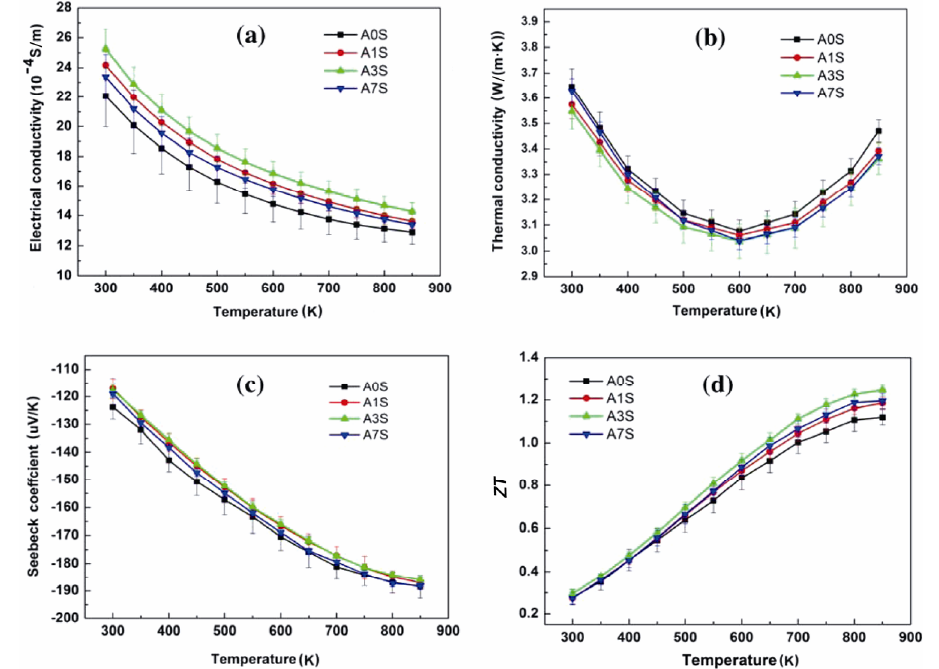
Fig. 10 (a) Electrical conductivity, (b) thermal conductivity, (c) Seebeck coefficient, and (d) ZT value of the samples A0S, A1S, A3S, and